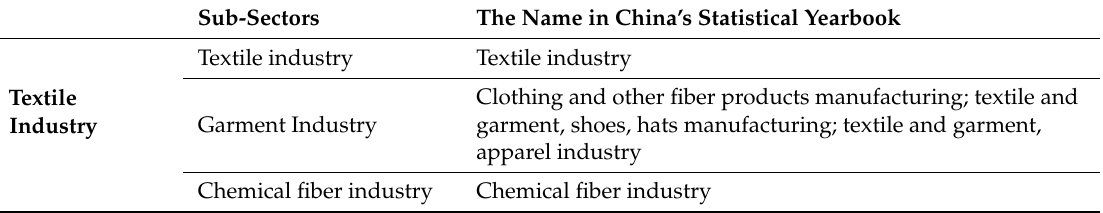
Table 2. China’s textile industry names and